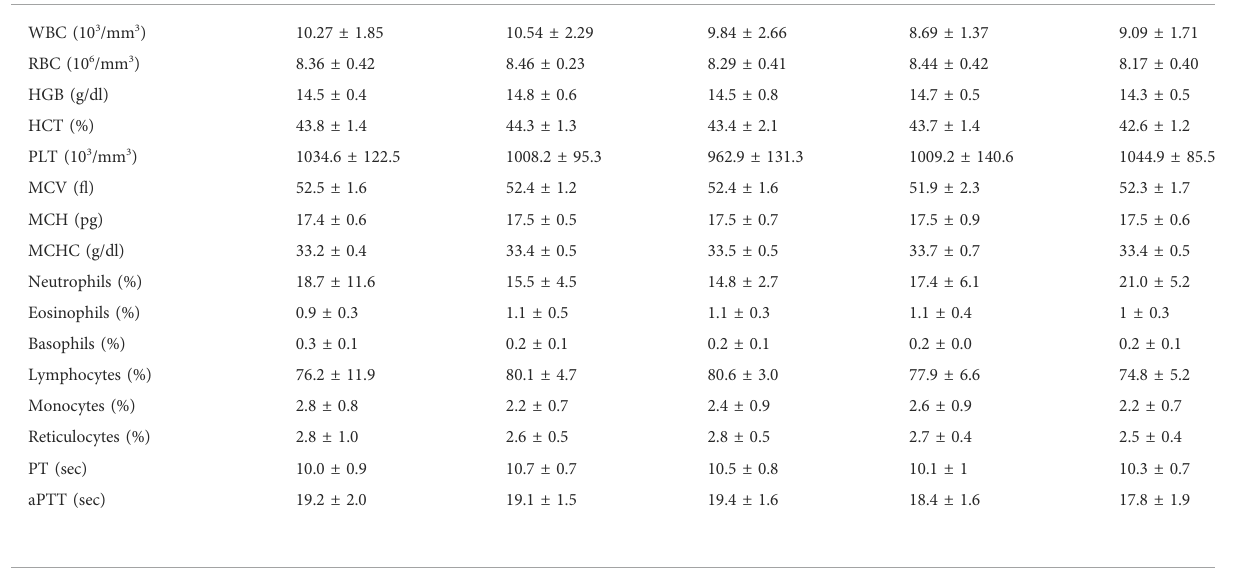
Dose of lac dye